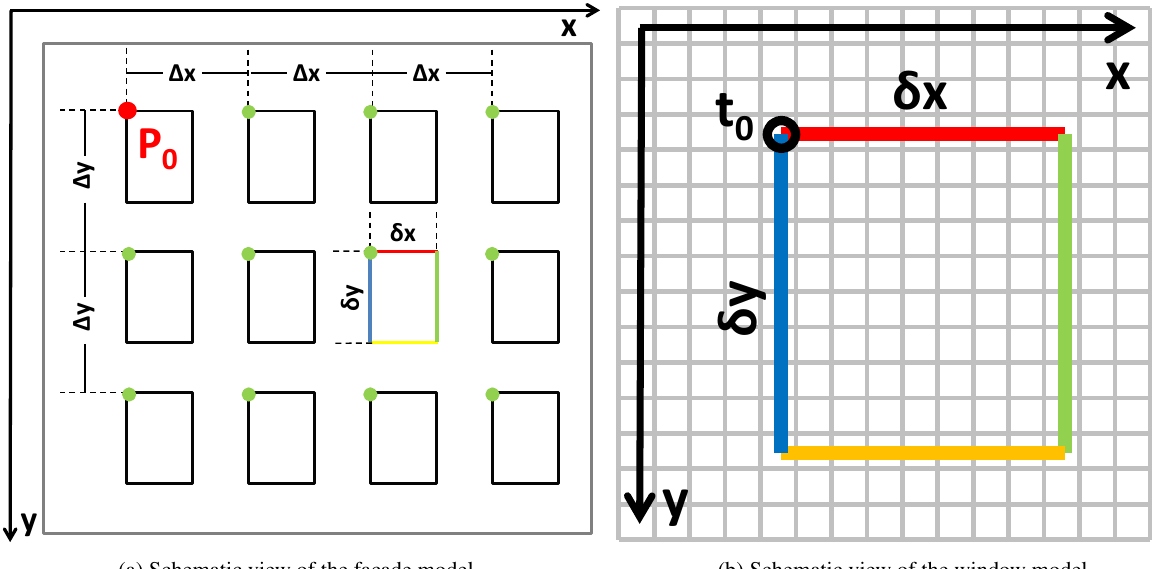
(a) Schematic view of the facade model. (b) Schematic view of the window model. Figure 5. (a) The facade is composed of single windows as depicted in (b). All origins of single windows (denoted t 0 in (b)) are marked with green points. The lattice is defined by the two spacings ∆ x and ∆ y , and the lattice origin P 0 . One window is exemplarily colored as in (a). (b) The discrete pixel locations of the window edges are determined by the origin of this specific image t 0 and the two parameters δ x and δ y defining the width and height of the window. The color correspond to the terms in equation (1).